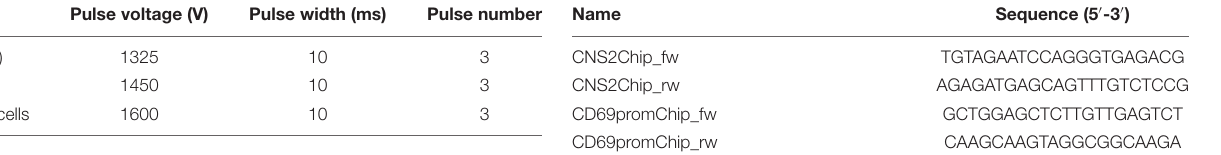
TABLE 4 | Primers sequences used for sense and antisense eRNA quantification.